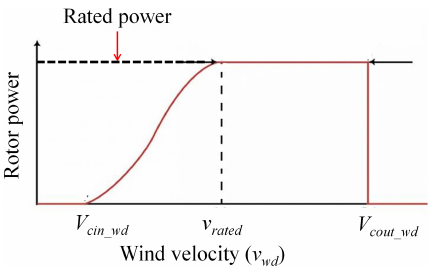
Figure 2. Wind velocity vs. rotor